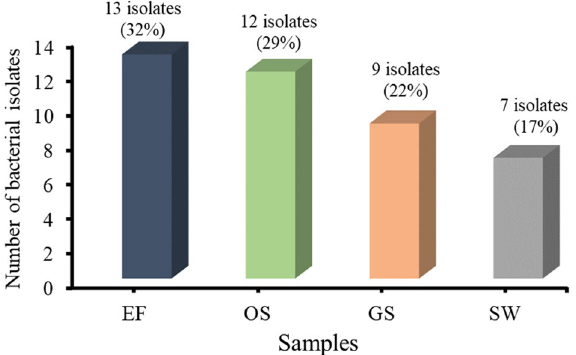
Figure 2. Number and percentage distribution of lead-tolerant bacteria from different contaminated sites. EF*: Electrical factory, OS: oil and soap company, GS: Gas station, and SW: soil near sewage